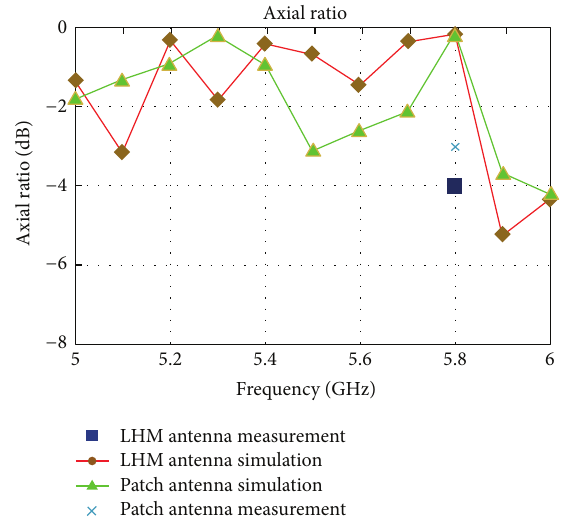
Figure 17: Axial ratio of reference antenna and FL-LHM